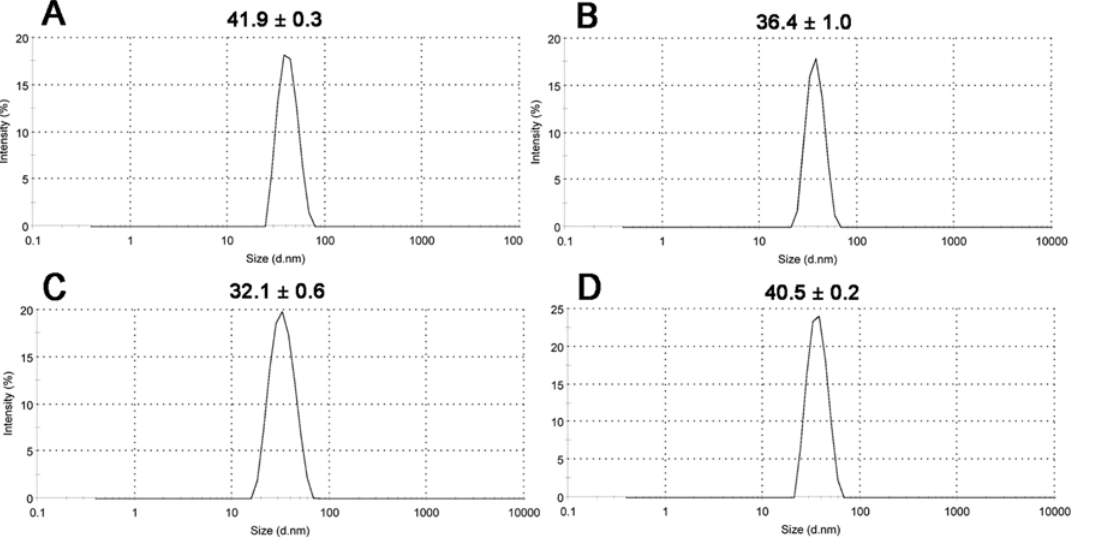
Fig 2. Analysis of virions hydrodynamic size using dynamic light scattering, for CaMV (A), EMCV (B), BMV (C) and BMMV (D).